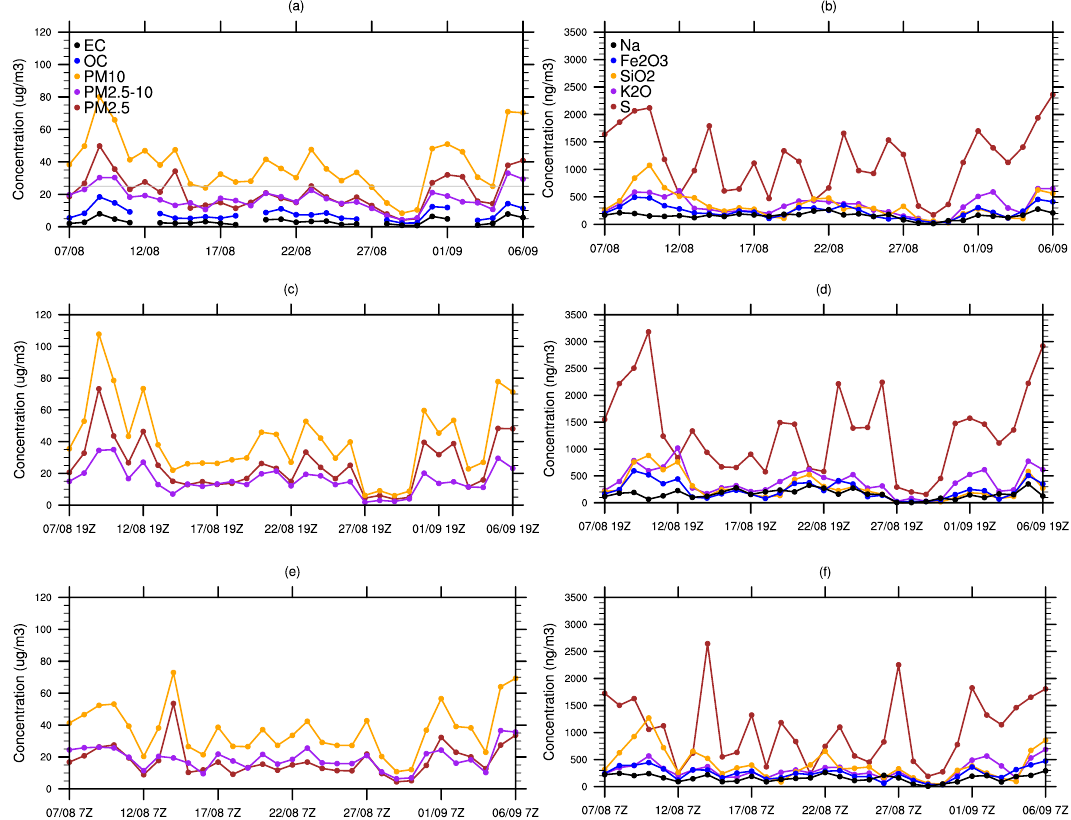
Figure 5. Daily (top), diurnal (bottom), and nocturnal (middle) mean concentrations for EC, OC, PM 10 , PM 2 . 5–10 , PM 2 . 5 (left panels), and Na, Fe 2 SO 3 , SiO 2 , K 2 O, and S (right panels). The PM 2 . 5–10 aerosol variable is defined as particulate matter with aerodynamic diameter between 2.5 and 10µm. The grey line indicates the WHO air quality standard for PM 2 . 5 (25µgm − 3 ).